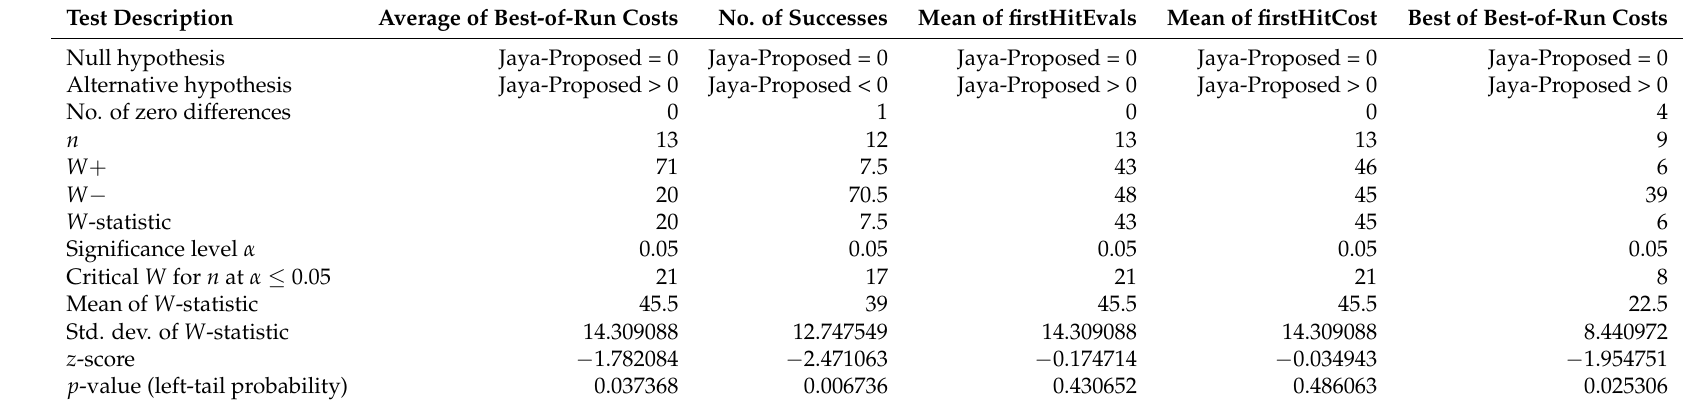
Table 17. Wilcoxon signed rank tests on the data in Tables